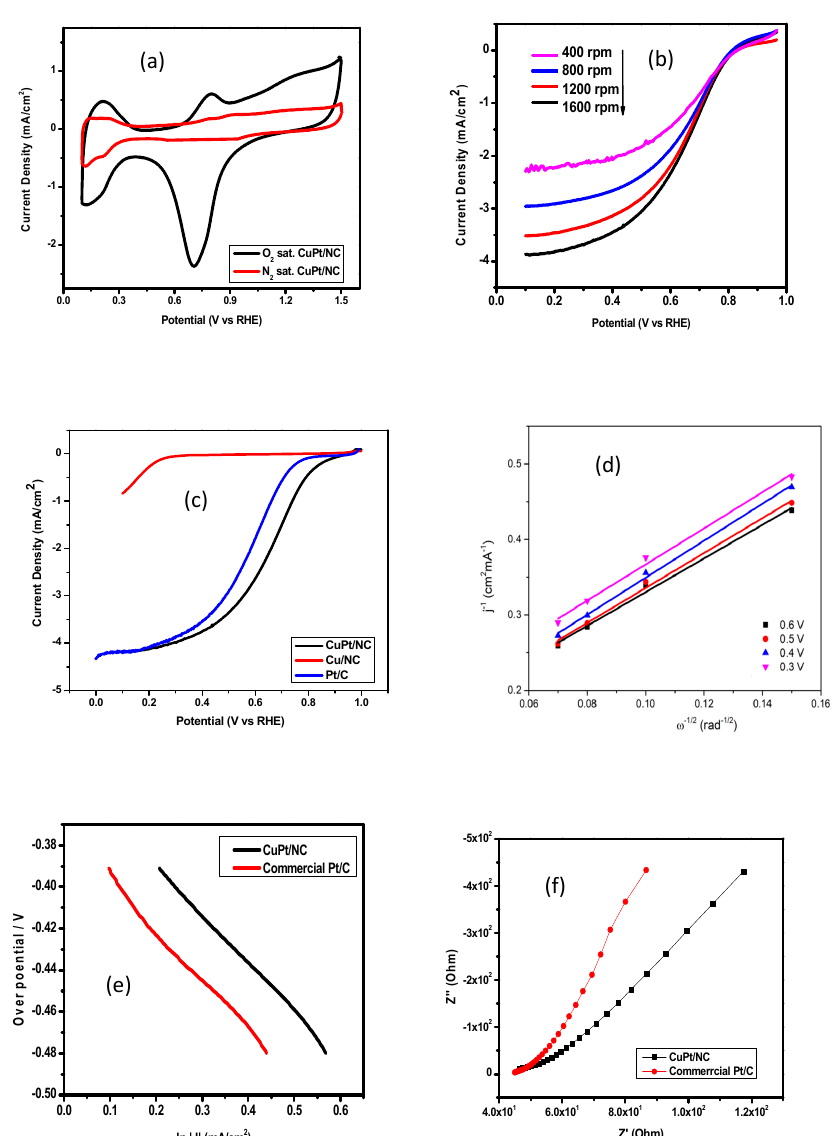
Figure 7. Evaluation of oxygen reduction reaction (ORR) activity for CuPt/NC ( a ) CV plots (with nitrogen and oxygen saturation 0.1 M HClO 4 solutions). ( b ) LSV plots at different rotation rates (rpm) for CuPt/NC. ( c ) Comparison of LSV curves of Cu/NC, CuPt/NC, and Pt/C with O 2 saturation in 0.1 M HClO 4 solution at 1600 rpm. ( d ) K–L plots from 0.6 V to 0.3 V, ω is the angular rotation speed. ( e ) Tafel slope comparison of CuPt/NC and Pt/C ( f) Nyquist plots for CuPt/NC and commercial Pt/C .